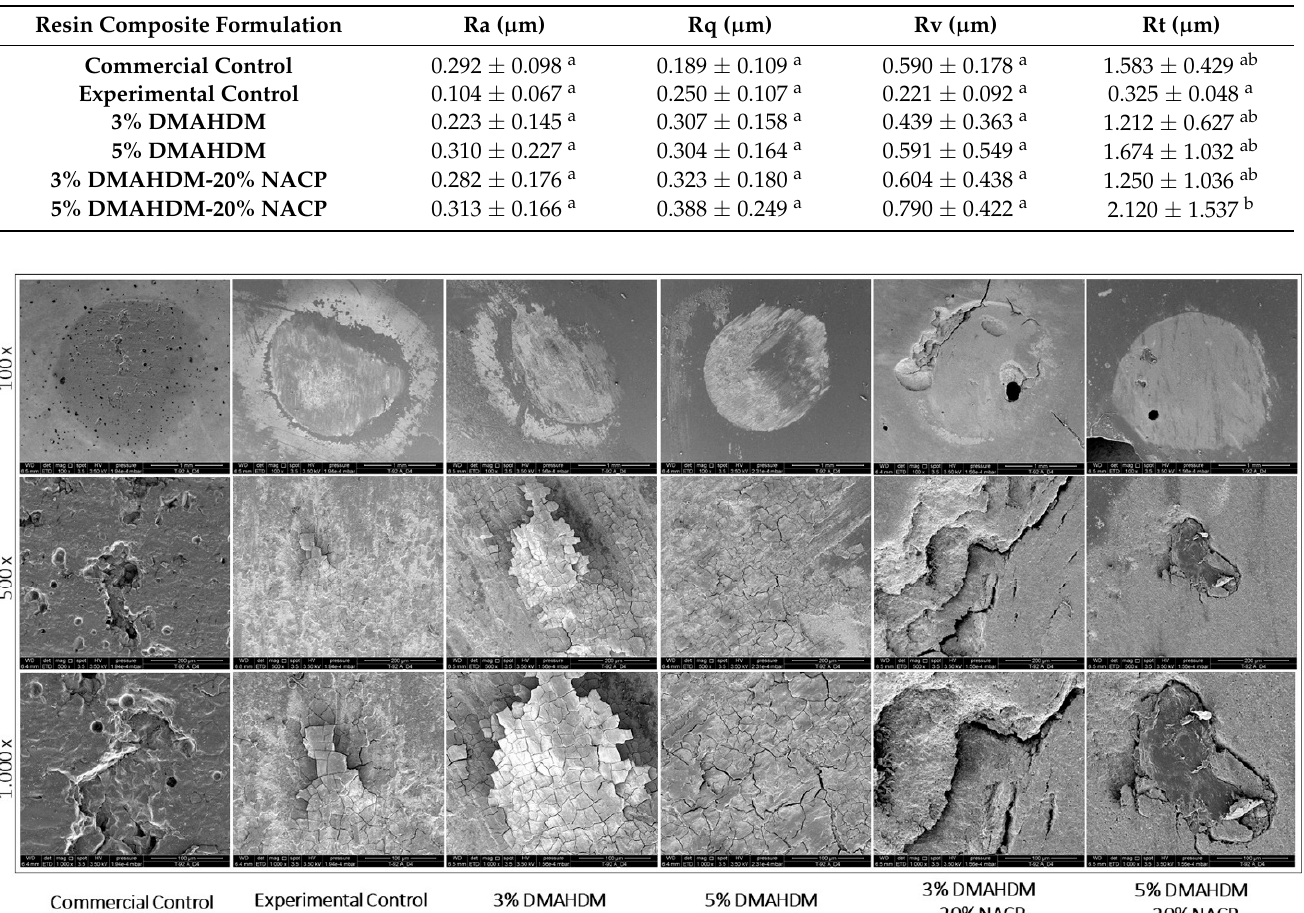
Figure 6. Scanning electron microscopy showing the topography changes on the composites’ surfaces following the simulated wear at ×100, ×500, and ×1000 magnification.